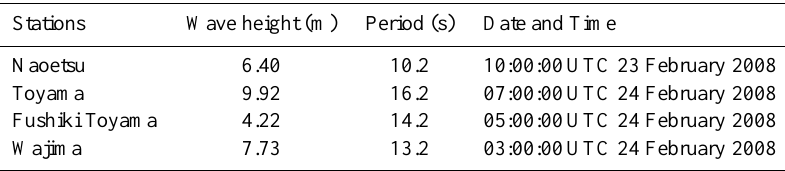
Table 1. Observed maximum values of wave characteristics in February 2008 (from Nationwide Ocean Wave information network for Port and HArbourS (NOWPHAS) of The Port and Airport Research Institute (PARI),